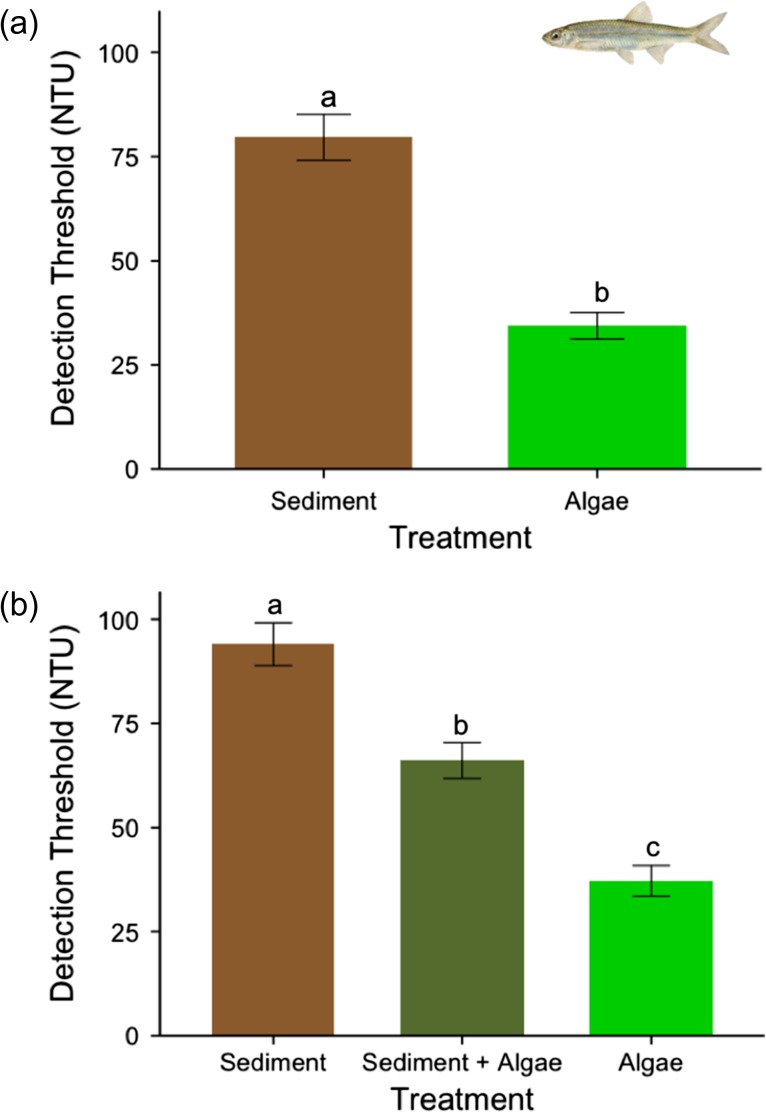
Mean (± standard error) detection thresholds for Emerald Shiner with individuals tested in (a) sedimentary turbidity (brown bar) and algal turbidity (green bar; n = 17, P < 0.001) and (b) all three treatments (subset n = 5) including a combination treatment (olive bar, P < 0.05). Each individual was tested twice under each treatments and the values for an individual within a treatment averaged. Post hoc pairwise comparison determined relationships between each treatment, as indicated by letters above bars.